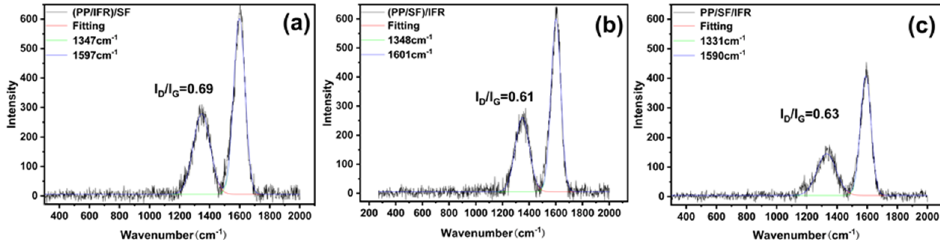
Figure 5. Raman spectra of the char residue of PP/SF flame − retardant composites. ( a ) (PP/IFR)/SF; ( b ) (PP/SF)/IFR; ( c ) PP/IFR/SF.